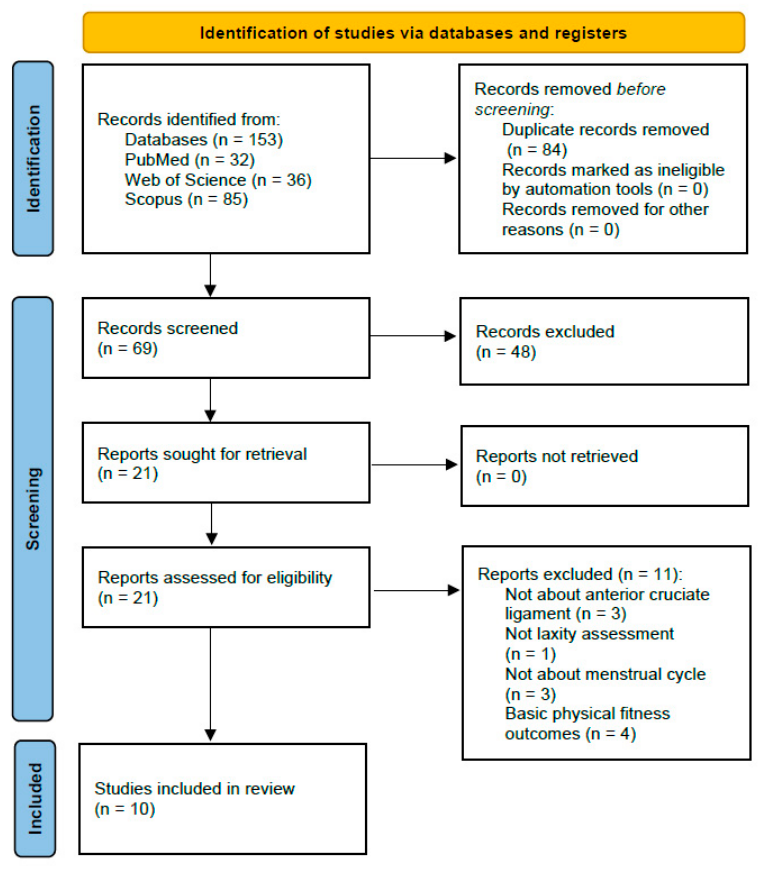
Figure 1. PRISMA Flow diagram.